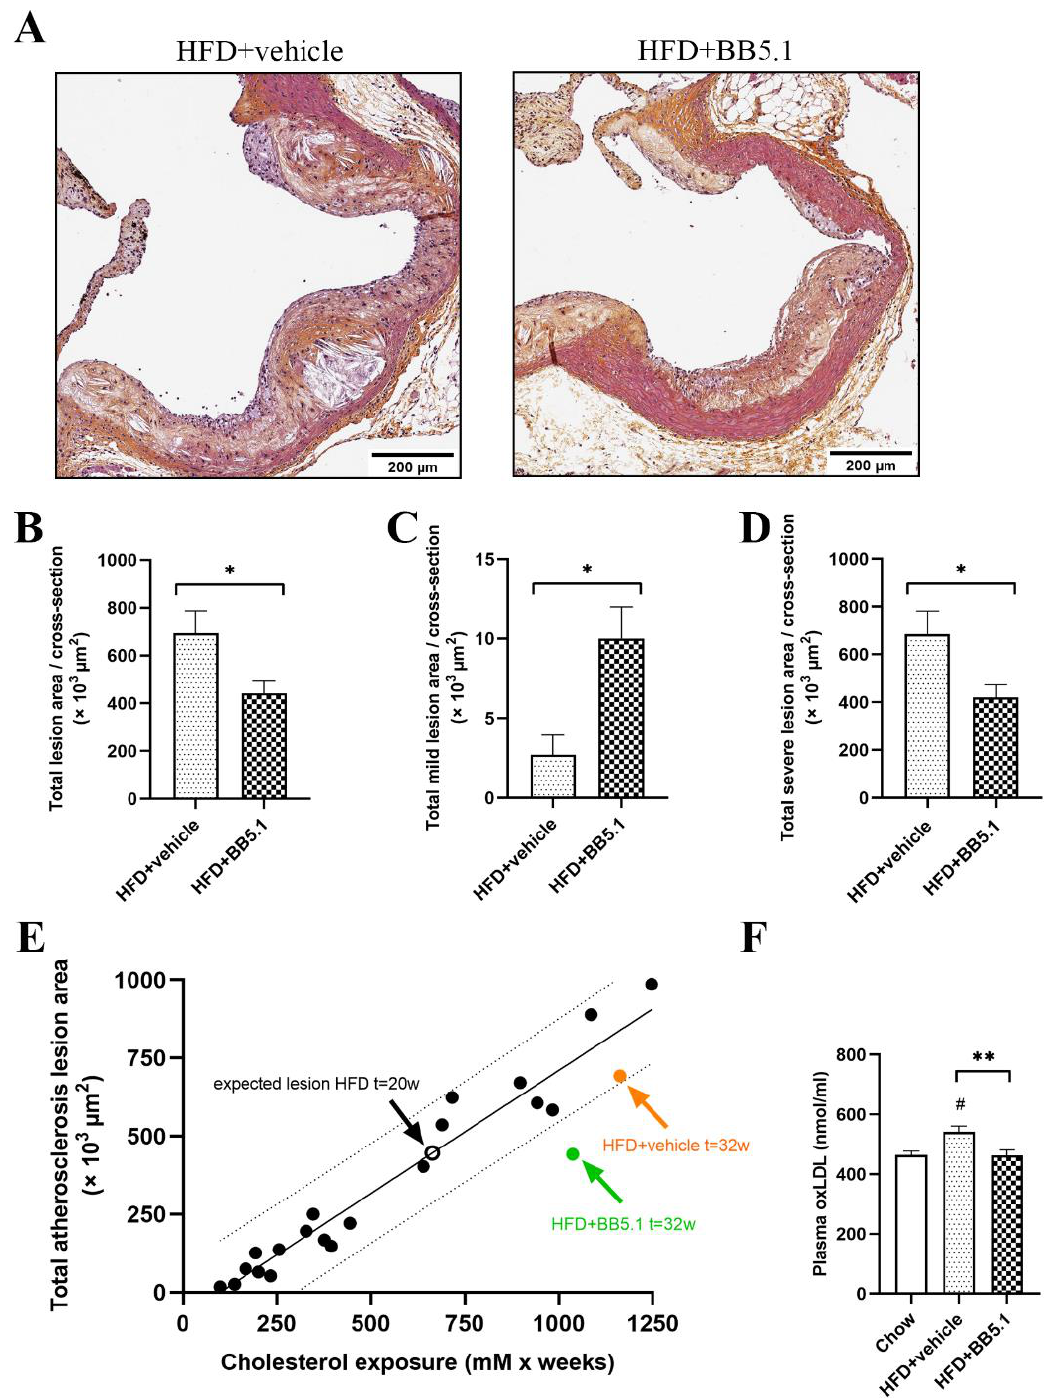
Figure 6. Anti-C5 treatment reduces atherosclerotic lesion size and severity. ( A ) Representative pictures of atherosclerotic plaque from HFD+vehicle and HFD+BB5.1 aortas, respectively. ( B ) Anti-C5 treatment reduces the total lesion area, ( C ) increased the area containing mild lesions and ( D ) decreased the lesion area containing severe lesions. ( E ) Linear relationship between cholesterol exposure and total lesion area in Ldlr-/-.Leiden mice based on control group data from historical studies, dashed lines indicate the 95% prediction band. ( F ) Plasma oxLDL is increased by HFD feeding and was reduced by anti-C5 treatment back to Chow level. Data are mean ± SEM. # p ≤ 0.05 Chow vs. HFD+vehicle. * p ≤ 0.05, ** p ≤ 0.01 HFD+vehicle vs. HFD+BB5.1.